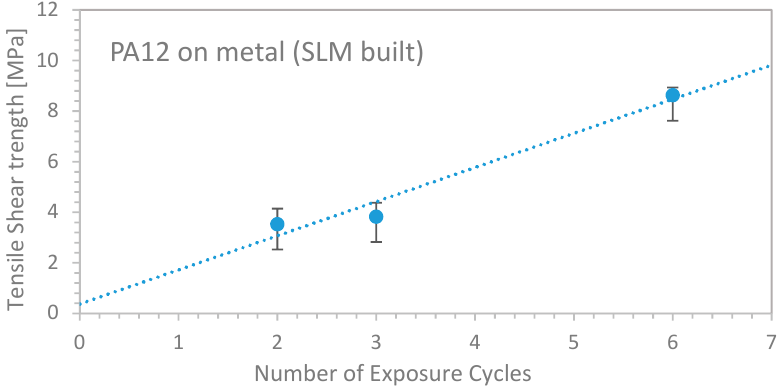
Figure 9. Tensile shear strength of PA12 sintered on SLM steel 1.2709 basic plate as a function of preceding exposure cycles.